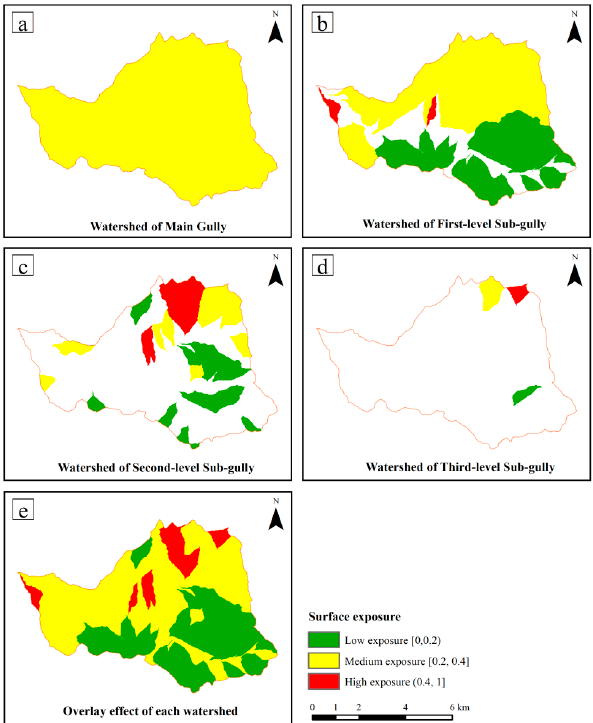
Figure 12. SE values of different watersheds corresponding to the different gully levels. ( a ) Watershed of the main gully; ( b ) Watershed of the first-level sub-gully; ( c ) Watershed of the second-level sub-gully; ( d ) Watershed of the third-level sub-gully; ( e ) Overlay effect of each watershed.